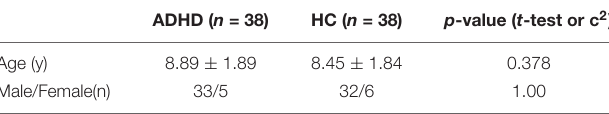
TABLE 1 | Demographic data of all patients and control